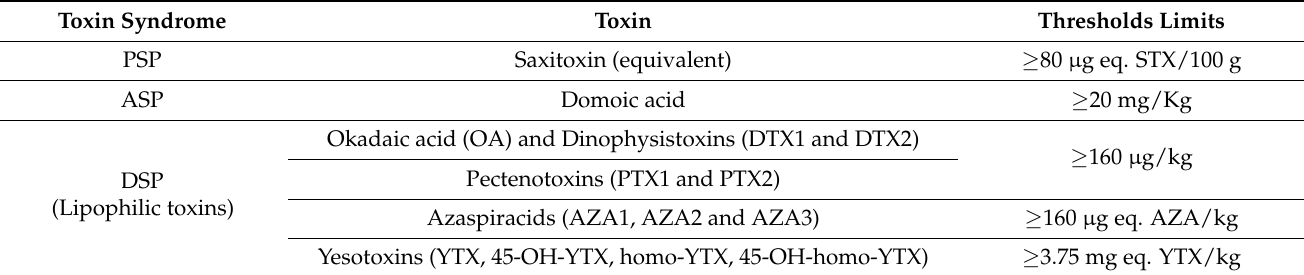
Table 1. Thresholds for marine toxins in exported bivalve molluscs (PSP = Paralytic shellfish poison, ASP = Amnesic shellfish poisoning, DSP = Diarrhetic shellfish poison) regulated by the Bivalve Mollusc Health Program (PSMB) in Chile